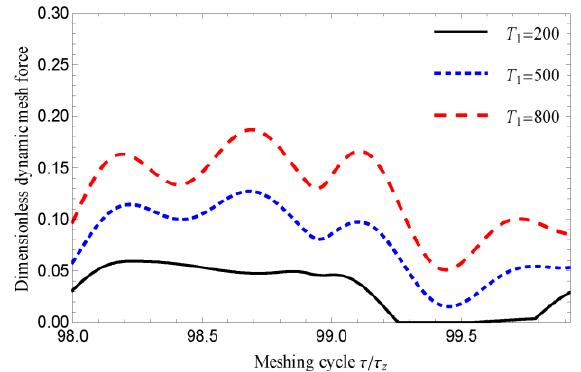
Figure 24. Dynamic mesh force of a single pair of teeth under different 𝑇 1 .